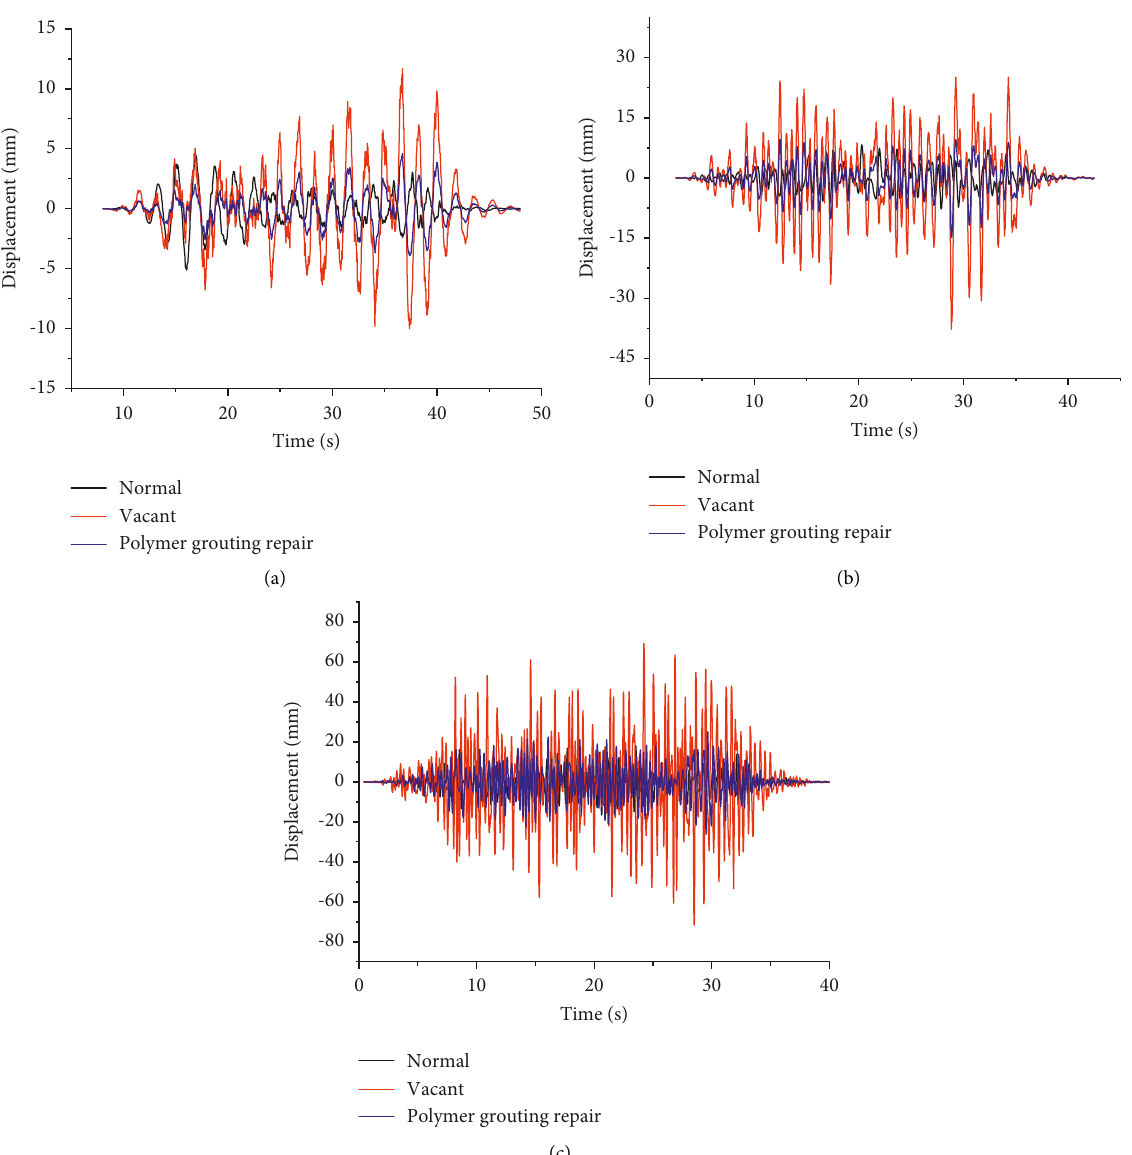
Figure 12: Time course curves of transverse vibration displacement of pipes under normal, vacant, and polymer grouting repair. (a) At 800m, wave speed v � 100m/s. (b) At 500m, wave speed v � 200m/s. (c) At 200m, wave speed v � 500